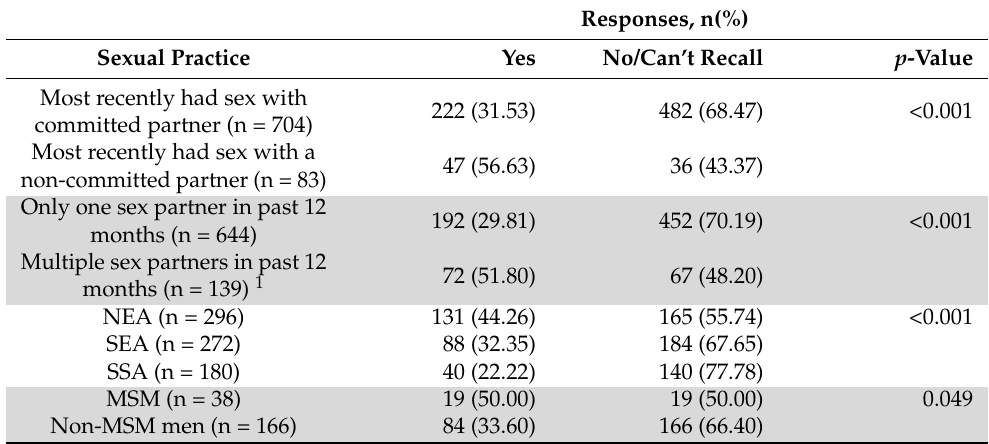
Table 4. Responses to condom use question (Did you use a condom the MOST RECENT time you had sex?), by sexual practices, birth region and sexual